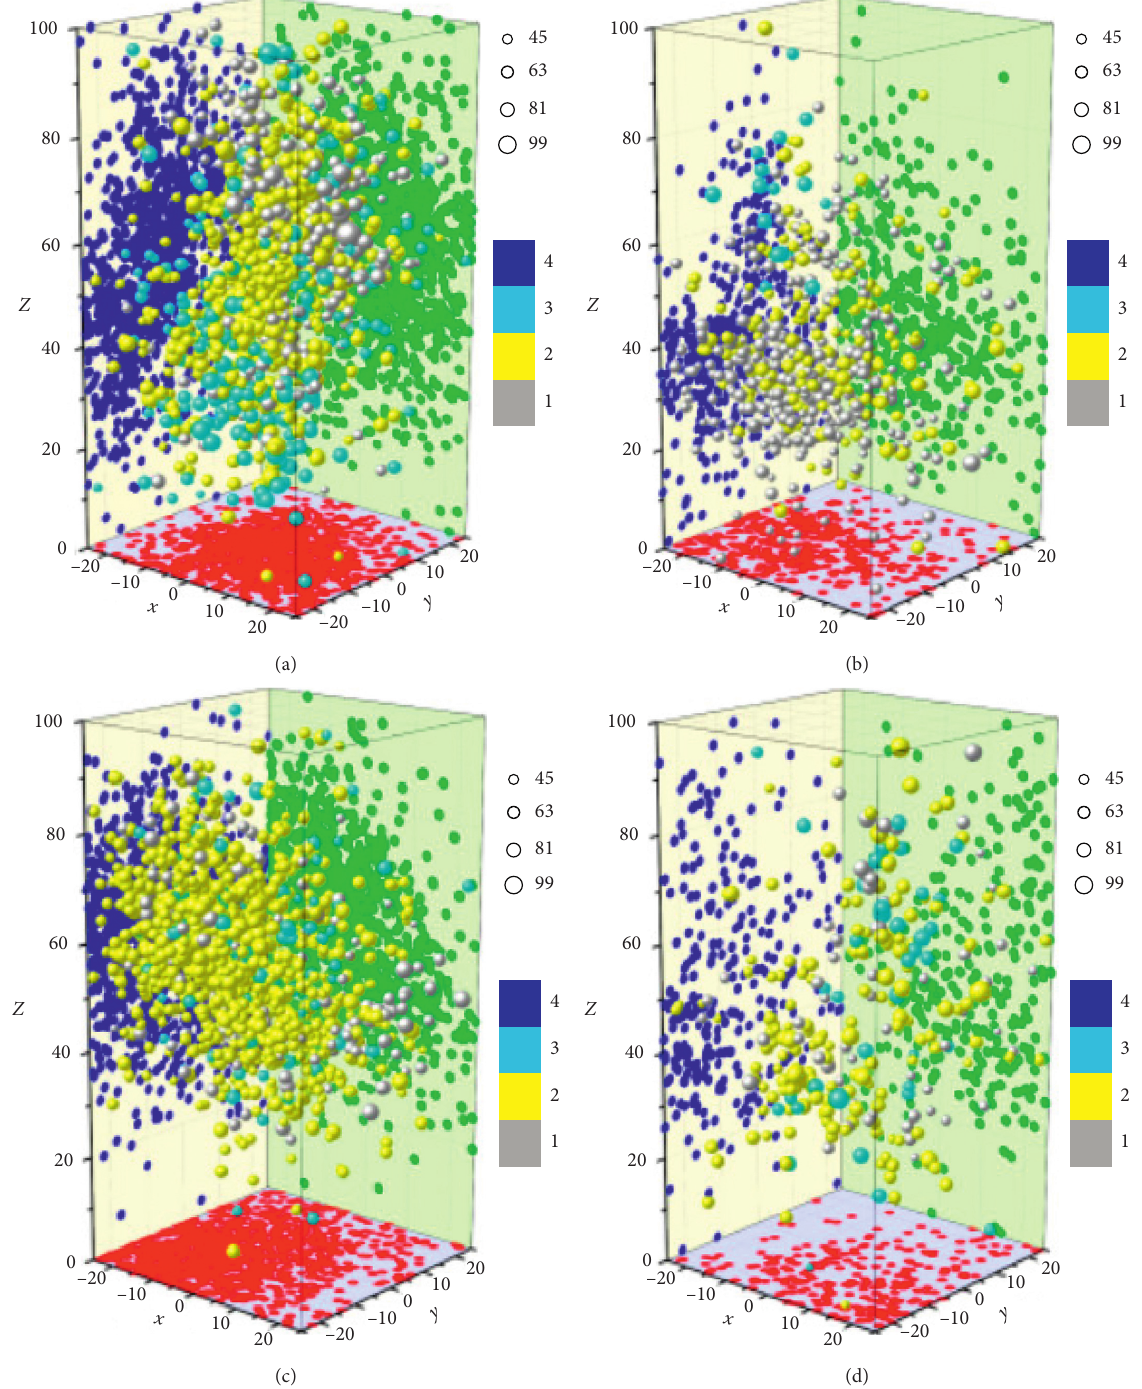
Figure 13: AE source three-dimensional positioning. (a) Coal sample no. 0. (b) Coal sample no. 2. (c) Coal sample no. 4. (d) Coal sample no.